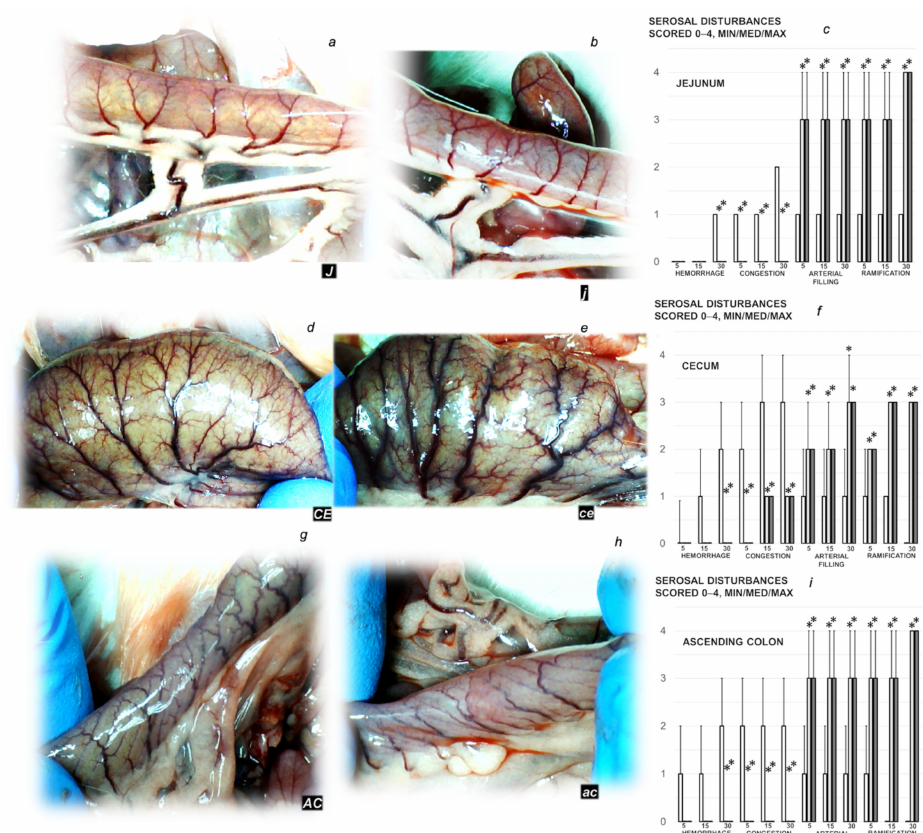
Figure 7. Serosal disturbances presentation (black letters a – i ). Serosal blood vessels gross presentation in the rats with the occluded end of the superior mesenteric vein in the rats that received BPC 157 therapy ( a , d , g ) or saline medication ( b , e , h ). Presentation in the jejunum ( J (BPC 157) ( a ), j (controls) ( b )), cecum ( CE (BPC 157) ( d ), ce (controls) ( e )) and ascending colon ( AC (BPC 157) ( g ), ac (controls) ( e )). Increased ramification and no congestion in BPC 157 treated rats, unlike advanced congestion and poor ramification in corresponding controls. Serosal disturbances (hemorrhage, congestion, arterial filling, ramification, scored 0–4, Min/Med/Max) assessment in the jejunum ( c ), cecum ( f ) and ascending colon ( i ) in the rats with ligated superior mesenteric vein at the end of the 30 min period following medication (BPC 157 10 µ g/kg (light gray bars), 10 ng/kg (dark gray bars); saline 5 mL/kg (white bars)) given intraperitoneally. Six rats/group/interval. * p < 0.05, at least, vs.